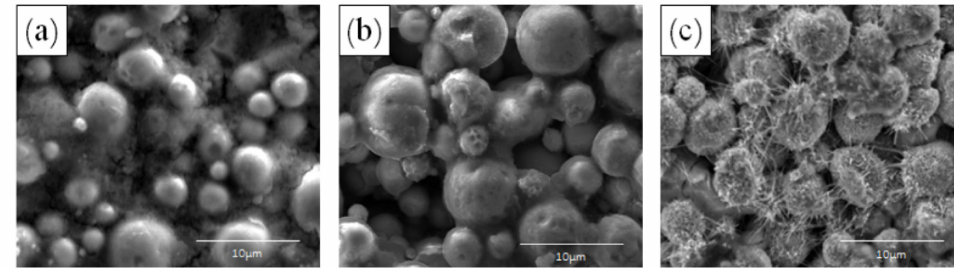
Figure 9. SEM images of WB zinc-based coatings baked at different temperatures. ( a ) 36H-400 ◦ C, ( b ) 36H-500 ◦ C and ( c ) 36H-600 ◦ C.